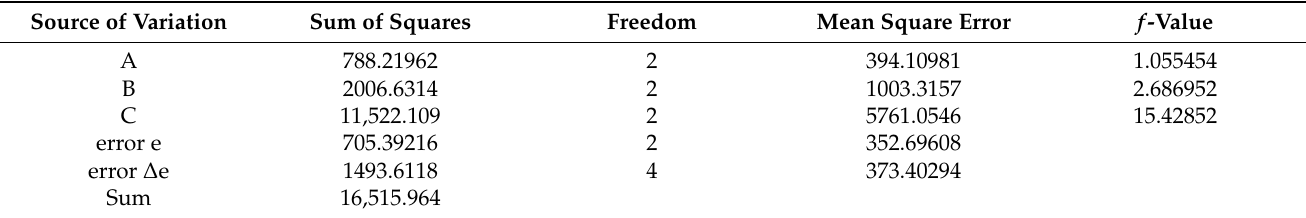
Table 5. The F -values of the ultimate compressive strength of the cube specimens at 7 d.